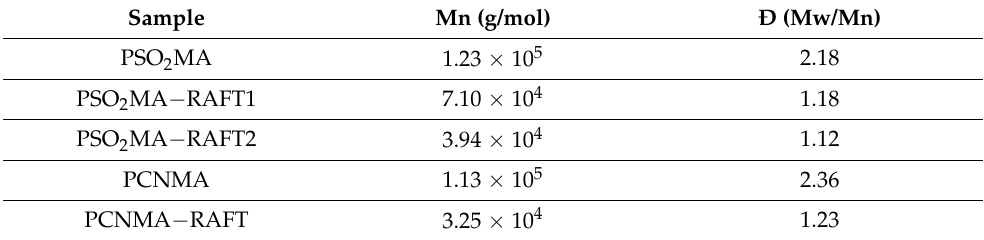
Table 2. Number-average molecular weight (Mn) and dispersity (Ð) values of synthesized polymers.